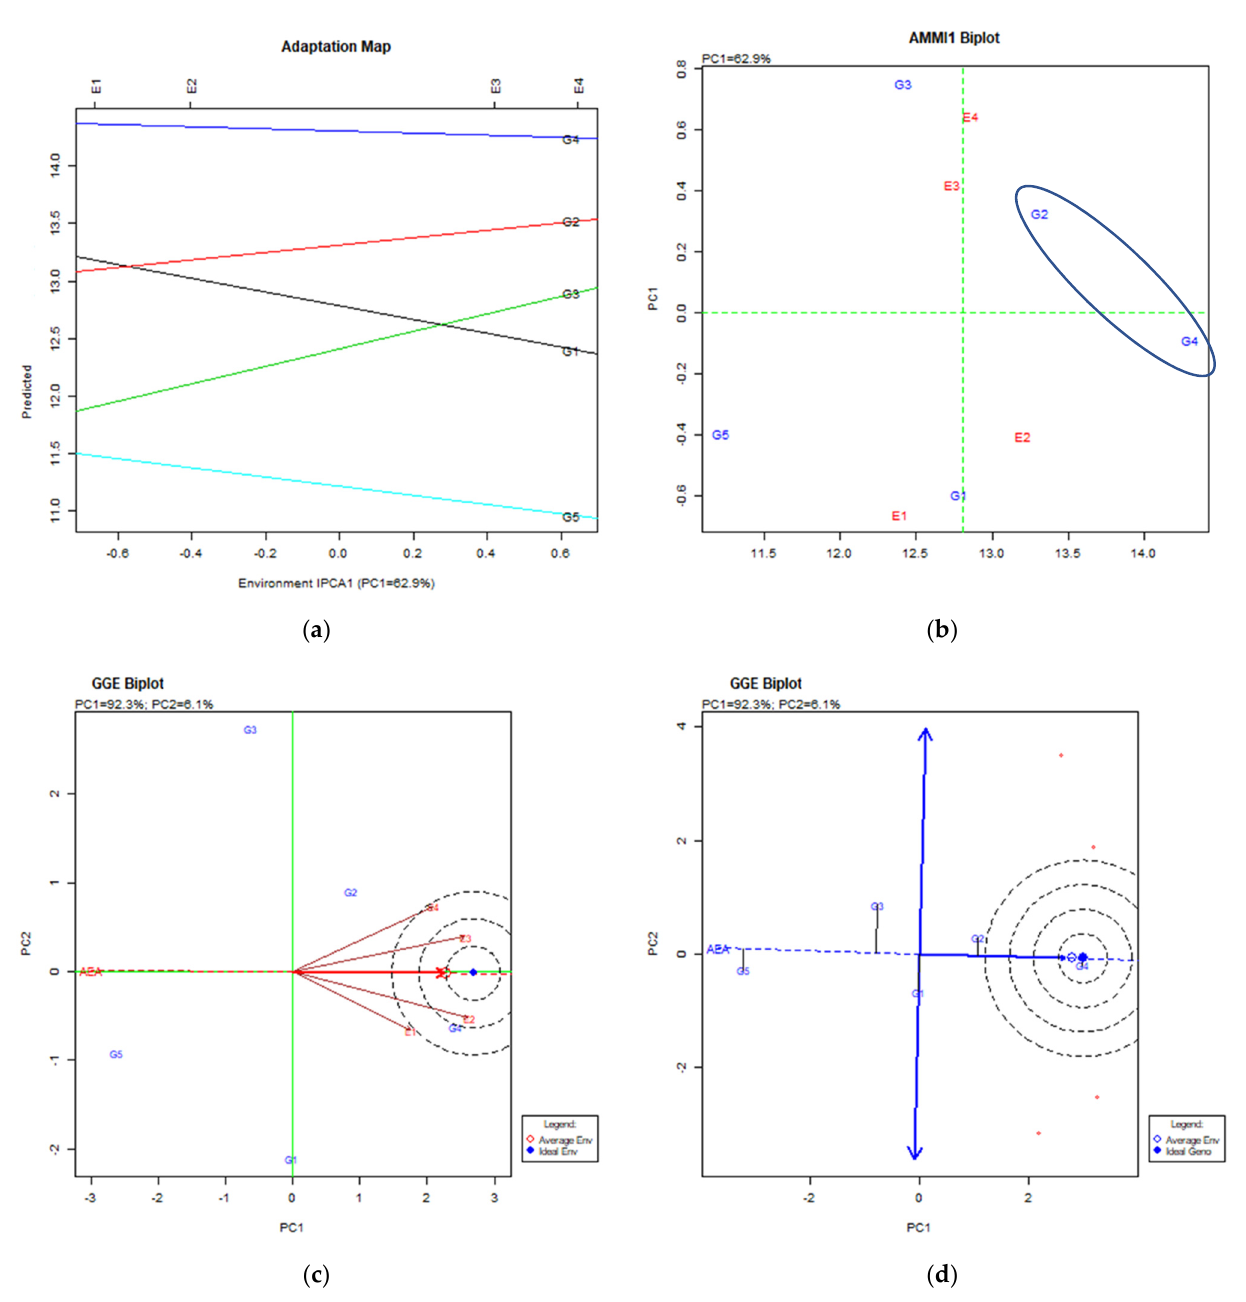
Figure 6. Stability analysis for number of pods per plant based on: ( a ) the adaptation map where the X-axis (PC1) visualizes the stability of cultivars over environments and the Y-axis—the performance of cultivars for the trait; ( b ) the AMMI1 biplot where the Y-axis is the one visualizing the trait performance and the X-axis (PC1) visualizes the stability of cultivars over environments; ( c ) the GGE biplot for environments depicting the stability of the environments over years via the placement as near as possible to the ideal and average environment; ( d ) the GGE biplot for cultivars depicting the stability of the cultivars over environments where the productive cultivars are those to the right on the AEA vector and the stable ones are those which are as close to the AEA axis as possible.